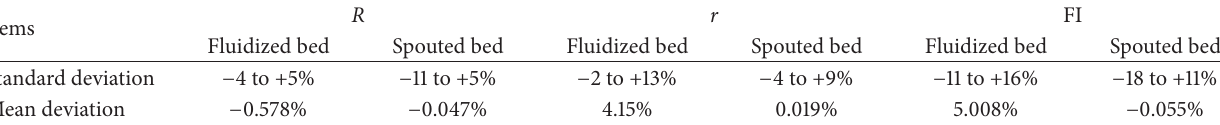
Table 3: Comparison results for bed dynamics of fine particles in fluidized/spouted